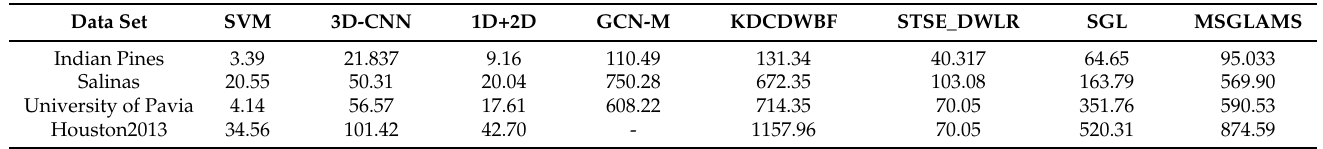
Table 12. runtime result (seconds) comparison on four data